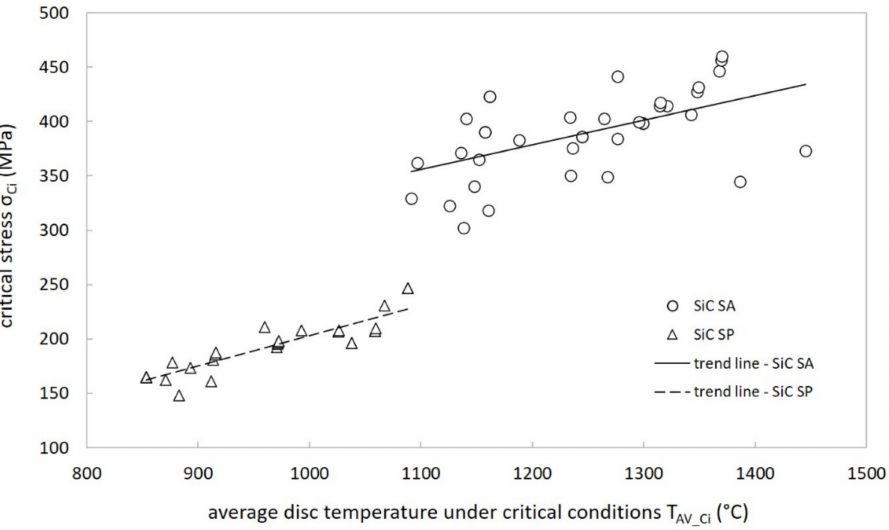
Figure 16. Critical stress versus temperature plot (RTPs approach) for both SiC SA and SP (T AV_Ci is calculated as the arithmetic average of T max and T min values reported in Tables 4 and